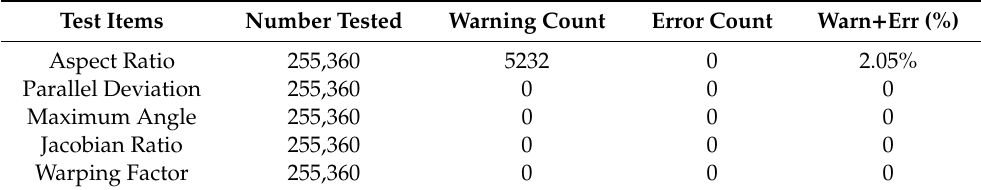
Table A1. The summary of the shape testing.